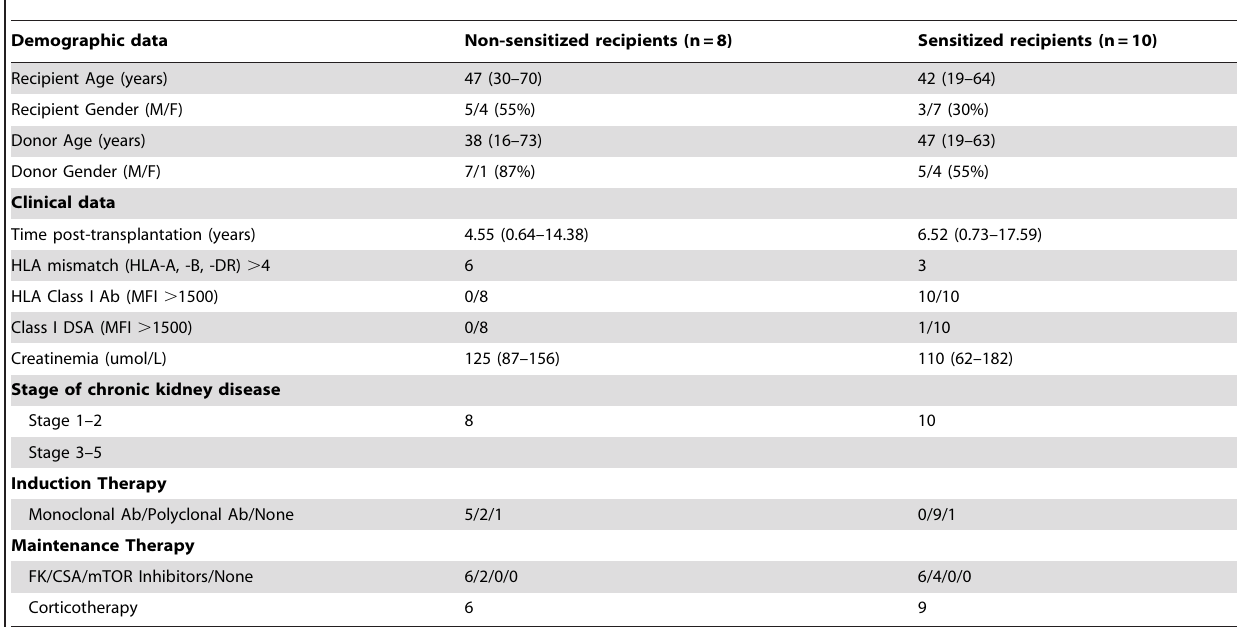
Table 1. Summary of demographic and clinical characteristics of patients analyzed using single HLA-A*0201 antigen coated beads.